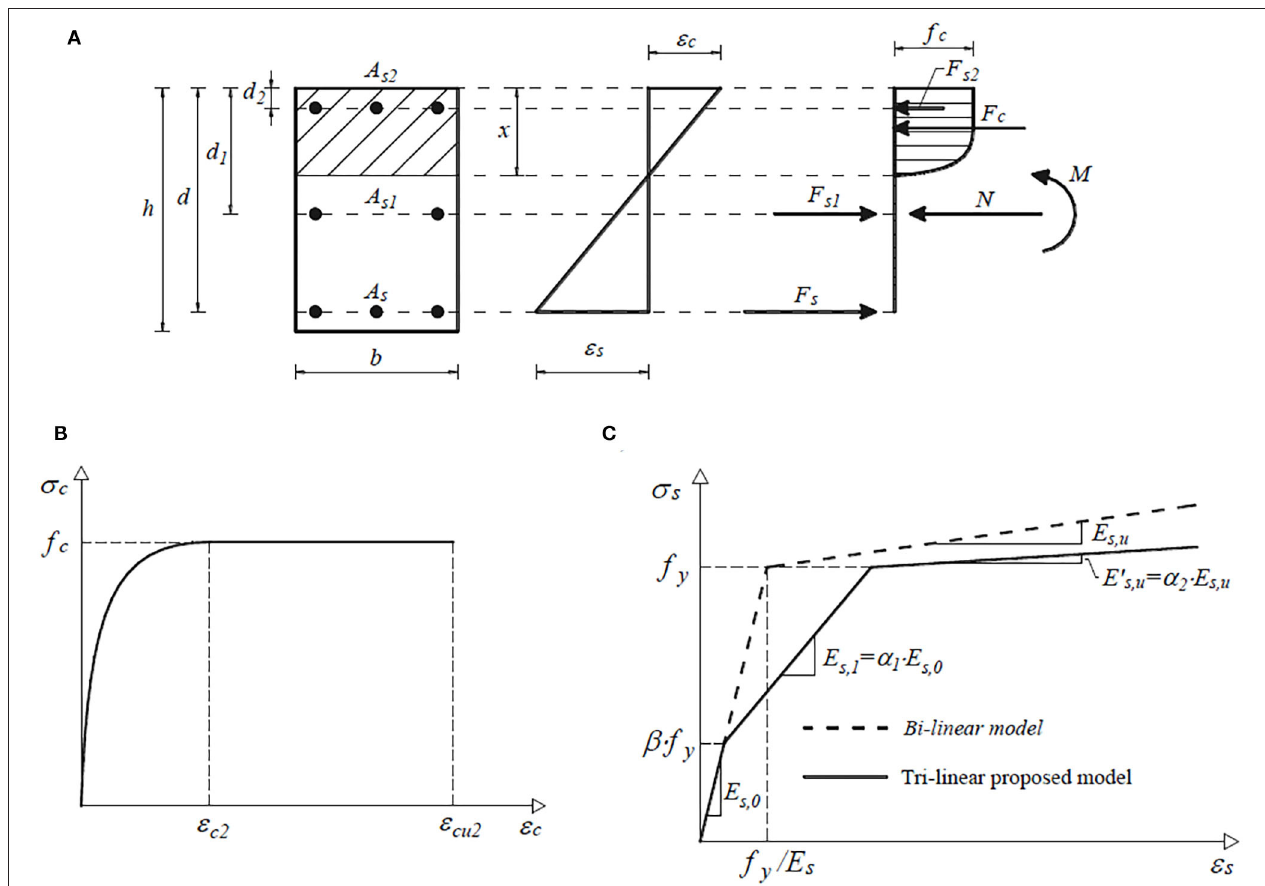
FIGURE 7 | (A) Idealized forces distribution in a section and idealized stress-strain diagrams: (B) concrete; and (C) reinforcing